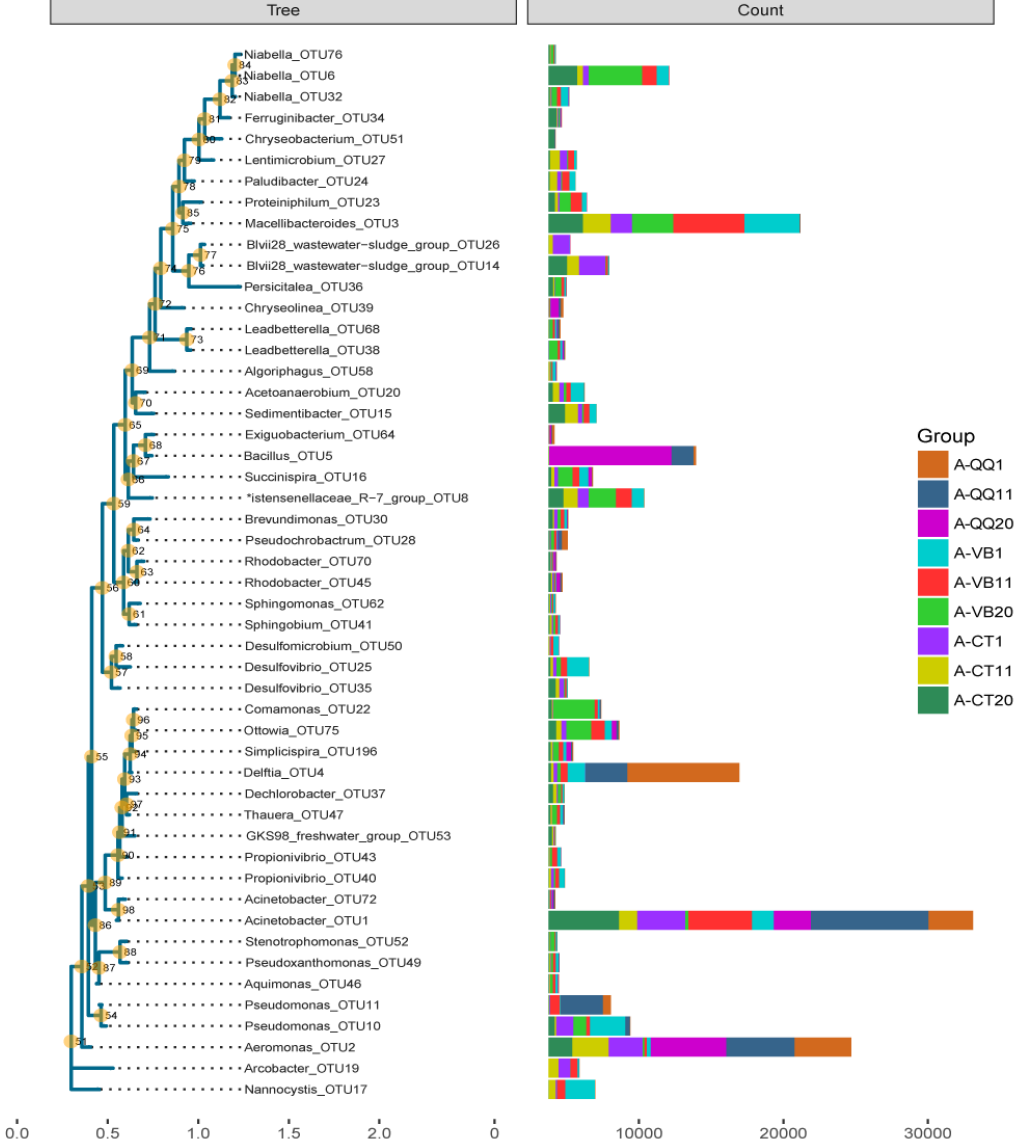
Figure 10. Plot of the phylogenetic tree showing the OTUs with the RA of the top 50 to the taxa level of genus in activated sludge with quorum quenching (QQ) beads (A-QQ), vacant beads (A-VB), and no beads (A-CT). The numbers at the branches were confidence values. The name after each branch indicates representative OTU annotations. The histogram to the left side represents the RA of each genus, and di ff erent colors were used to distinguish di ff erent